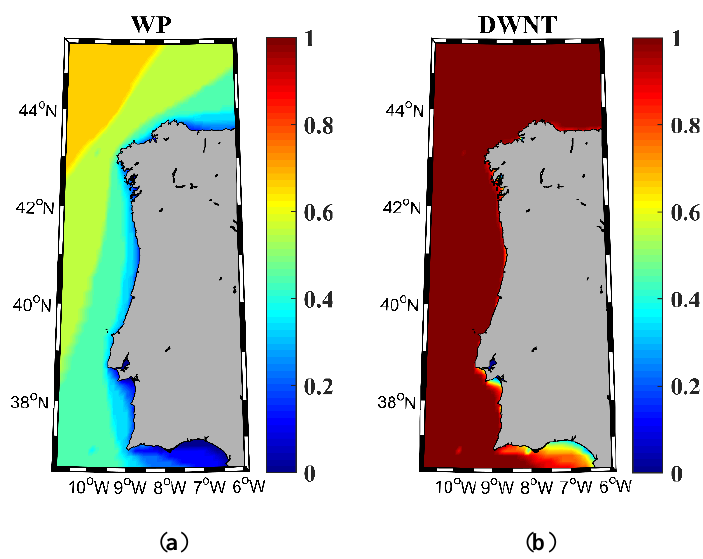
Figure 2. Richness indices for wind energy resource. Annual average wind speed ( a ), rich level occurrence ( b ), and downtime ( c ) in the NW Iberian Peninsula for the near future (2026–2045).